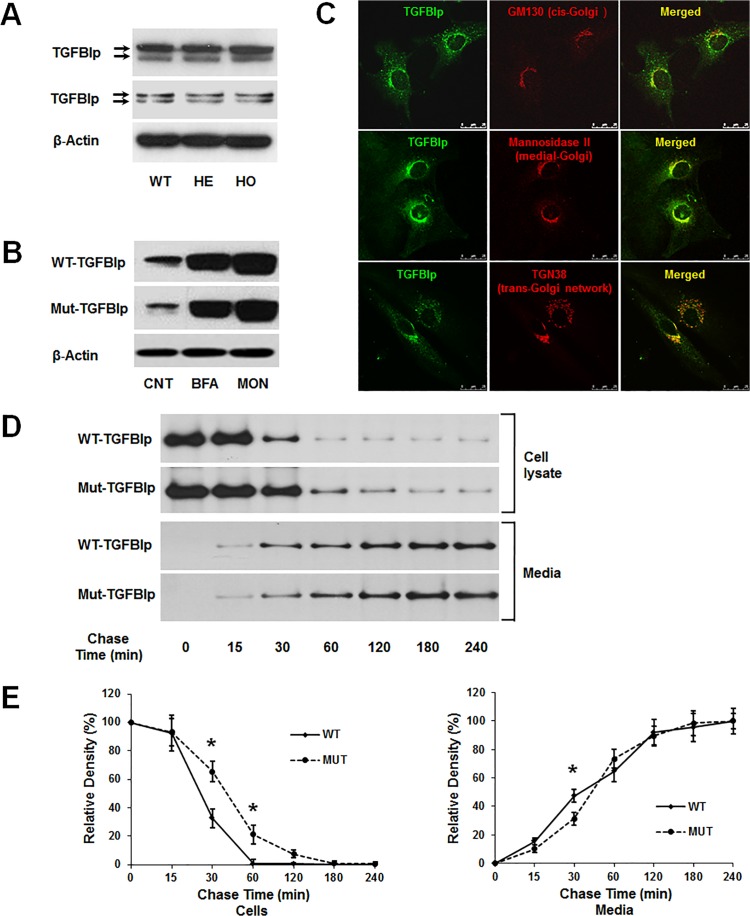
Expression and secretion of TGFBIp in wild-type (WT) and heterozygous (HE) or homozygous (HO) mutant primary corneal fibroblasts.
A. Western blot analysis of TGFBIp in cell lysates (upper panel) and conditioned media (lower panel) of WT, HE, and HO cells. β-actin was used as a loading control. Molecular weight markers (in kDa) are indicated. B. Secretion of WT and mutant TGFBIp was inhibited by treatment with brefeldin A (BFA) and monensin (MON). C. TGFBIp co-localized with markers of cis-Golgi (upper panel), medial-Golgi (middle panel), and trans-Golgi (lower panel) in cortical cells. Representative confocal images of immunofluorescence staining of TGFBIp (green) with GM130, mannosidase II, and TGN38 (all red) are shown. Overlapping areas are displayed in yellow in the merged images. Bars = 25 μm. D. Secretion of mutant TGFBIp is delayed in GCD2 corneal fibroblasts. Corneal fibroblasts from a patient with a homozygous TGFBIp mutation and a WT control were pulse-labeled for 20 min using 35S-cysteine and then incubated for 0, 15, 30, 60, 120, 180, and 240 min in unlabeled media before immunoprecipitation of TGFBIp from cell lysates and conditioned media. Phosphorimaging was performed after SDS-PAGE to detect TGFBIp. One representative experiment is shown. E. Quantitation of the experiment presented in D. Triplicate lysate samples were analyzed. *P < 0.05.